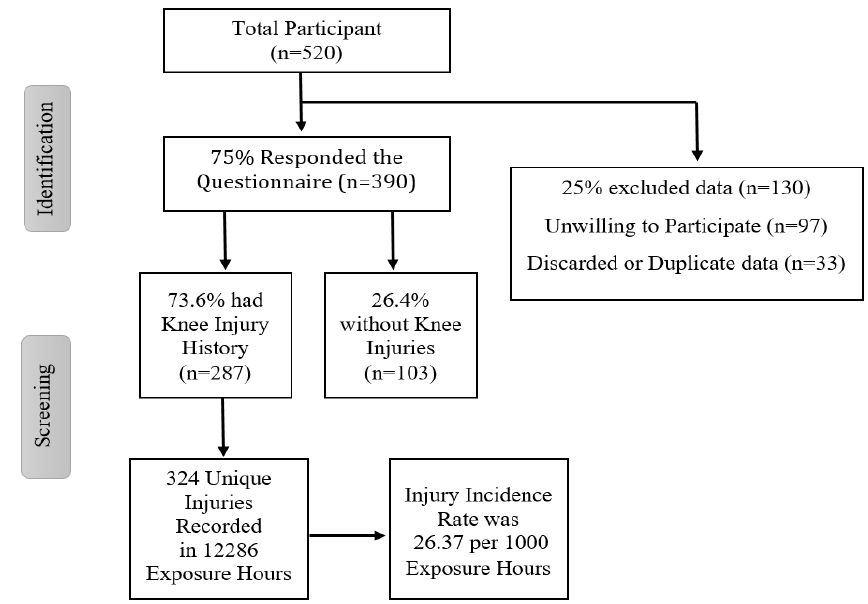
Figure 1. Flowchart of participants included in the study. The most common treatment methods used were self-treatments ( n = 130, 33.3%), physiotherapy ( n = 56, 14.4%), and use of other self-medication techniques ( n = 25, 6.4%). Seventy-one athletes (18.2%) did not use any treatment, and three participants (0.8%) used knee braces or had surgery. Further injury information is presented in Figure